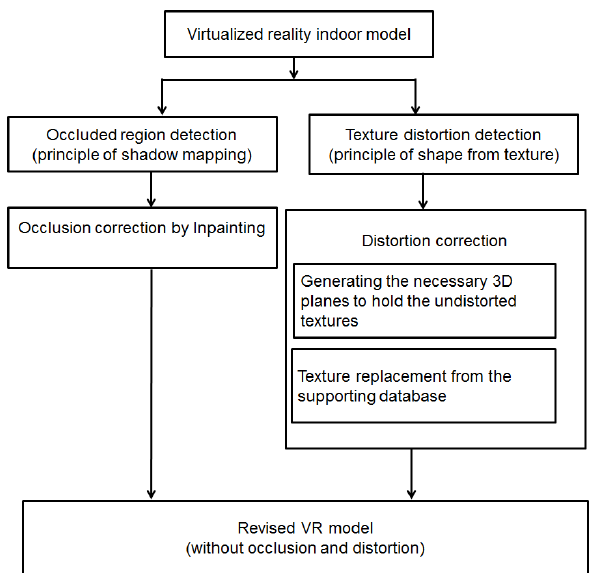
Figure 1: Virtualized reality indoor model and occlusion and dis- tortion